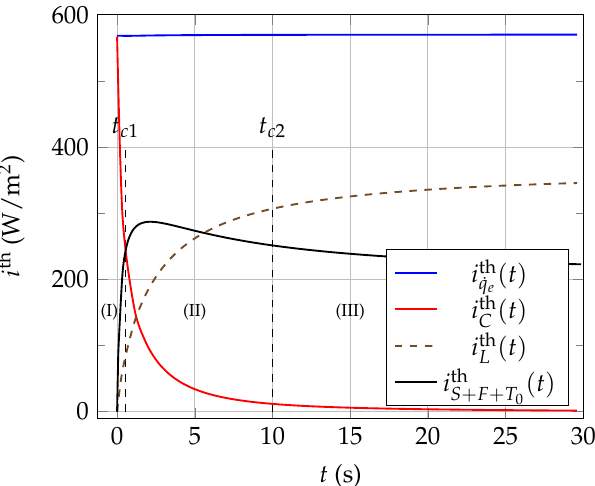
Figure 16. Evolution of the different thermal current densities as a function of time t ∈ [ 0,30 ] s, calculated at r = a c , in the case of NTC3 immersed in pure glycerol at rest, when: L i = 5.0mm, v 0 = 6.90V, and T 0 = 25 ◦